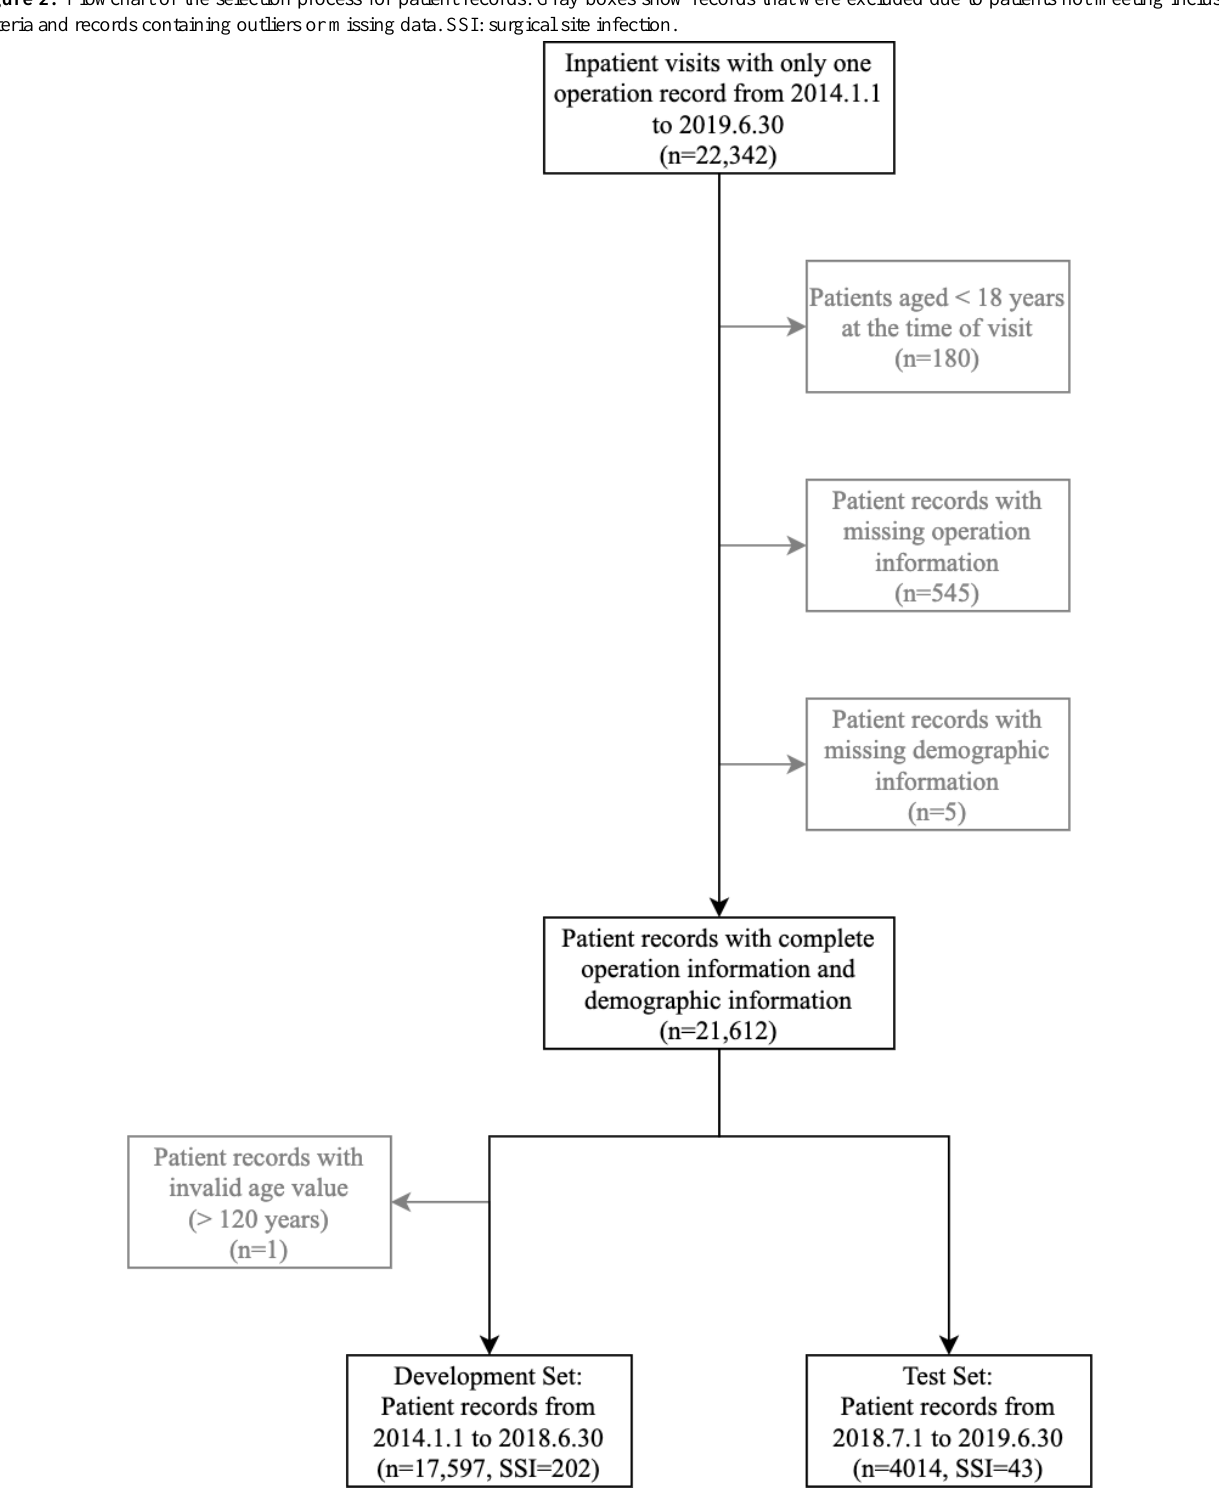
Figure 2. Flowchart of the selection process for patient records. Gray boxes show records that were excluded due to patients not meeting inclusion criteria and records containing outliers or missing data. SSI: surgical site